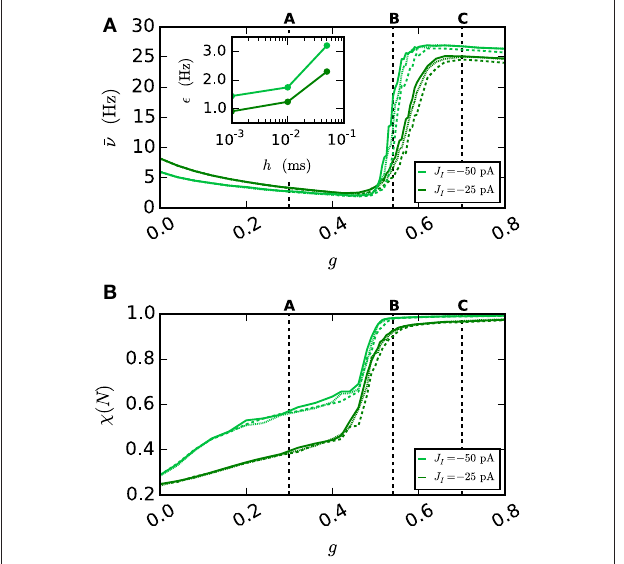
FIGURE 11 | Overhead of gap-junction framework for network with only chemical synapses. VP denotes the overall number of processes used in line with our distribution strategy described in Section 2.4. In this and all subsequent figures shades of blue indicate the JUQUEEN supercomputer. (A) Triangles show the maximum network size that can be simulated in the absence of gap junctions (Test case 3 ). Circles show the corresponding wall-clock time required to simulate the network for 1 s of biological time. Dark blue symbols indicate the results with the 4th generation simulation kernel of NEST without the gap-junction framework and blue curves and symbols are obtained with the framework included. (B) Increase of time (blue circles) and memory consumption (blue triangles) due to the gap-junction framework in percent compared to the 4th generation simulation kernel.